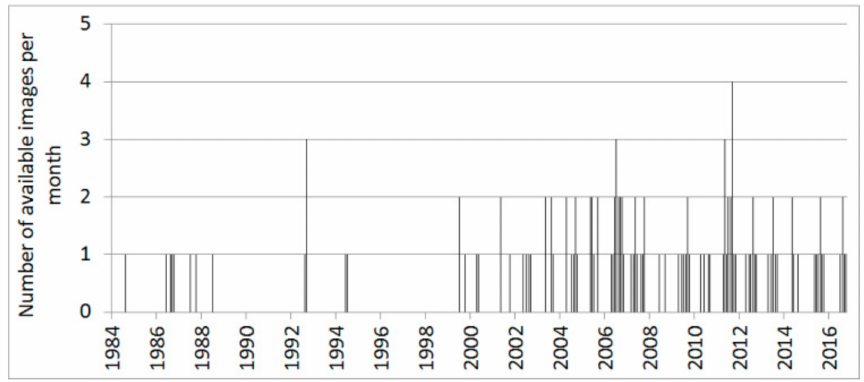
Figure 4. The monthly number of available images (1984–2016) for the study